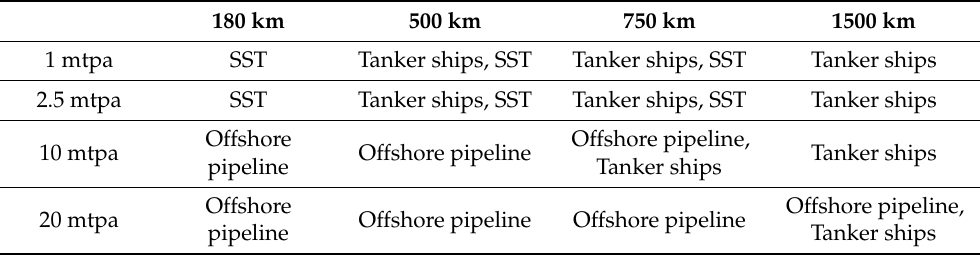
Table 16. Transportation method with lowest costs. The differences in costs are low, and within 15% for cases where two transportation methods are present in a